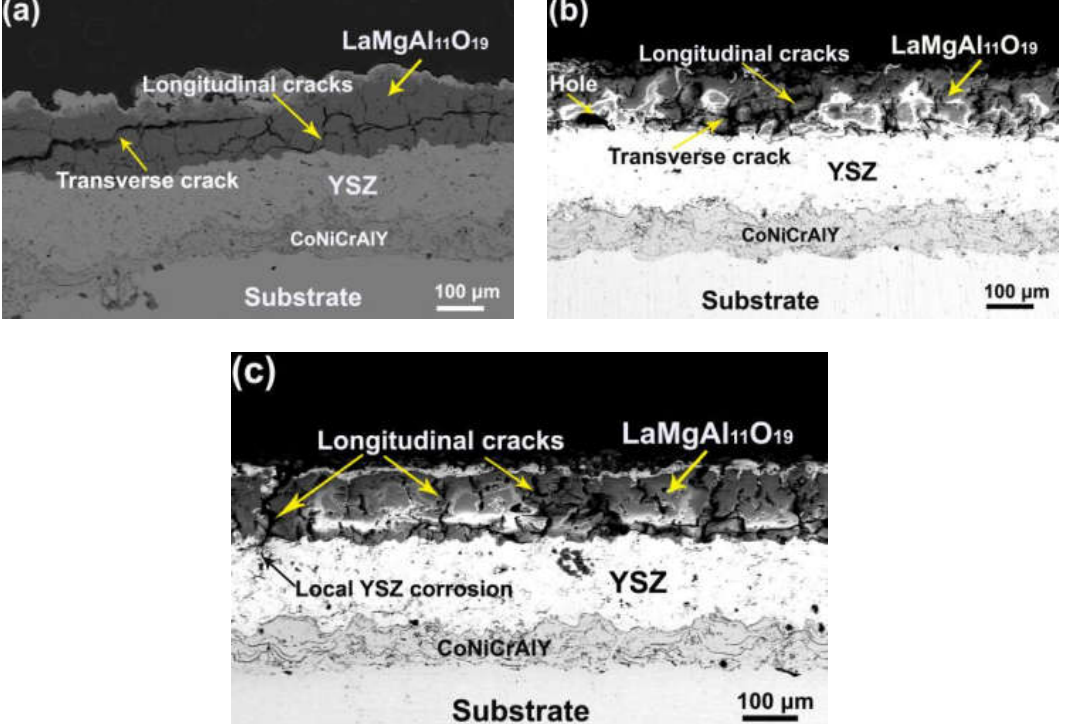
Figure 6. Cross-sectional SEM images of coatings after 12 h corrosion test: ( a ) S0, ( b ) S1, and ( c ) S2.